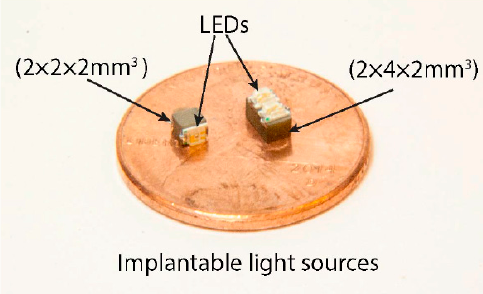
Figure 48. Mounted micro-light sources on PZT cubes on a US penny. One LED, and two LEDs are mounted on each side of 2 × 2 × 2 mm 3 and 2 × 4 × 2 mm 3 PZT, respectively [207]. Copyright © 2015, IEEE.